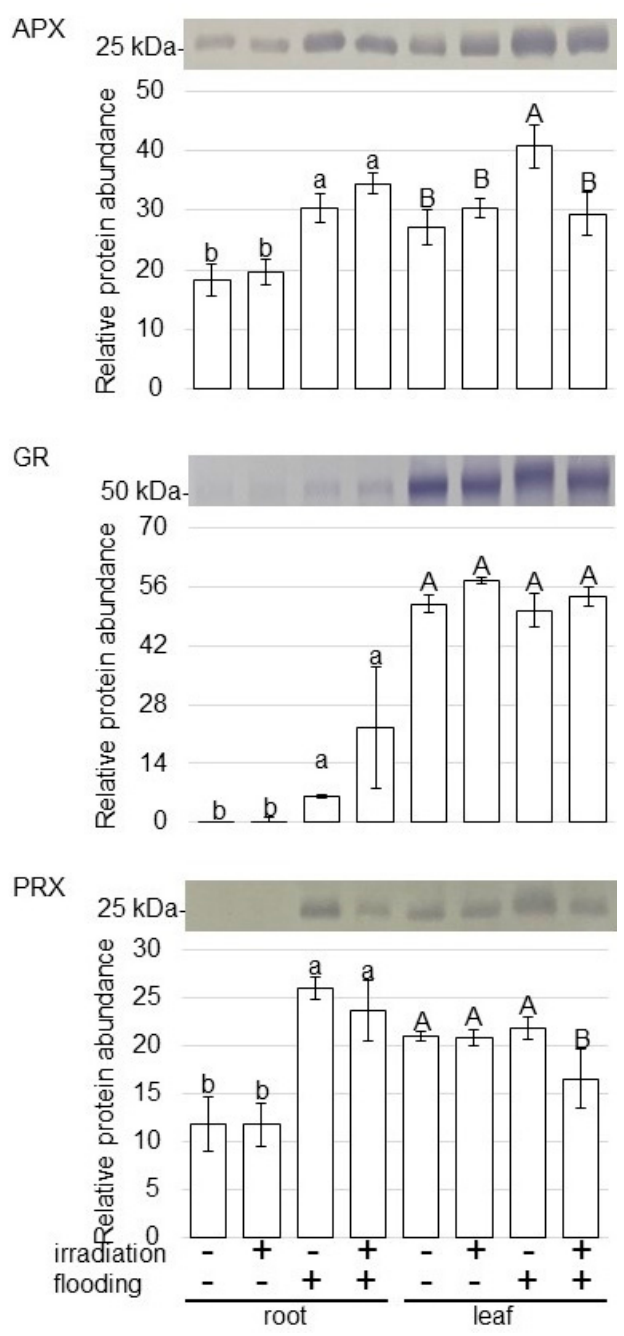
Figure 6. Immunoblot analysis of proteins involved in ROS scavenging in wheat irradiated with millimeter waves under flooding stress. Proteins extracted from roots and leaves of wheat seedlings were separated on SDS-polyacrylamide gel by electrophoresis and transferred onto membranes. The membranes were cross-reacted with anti-APX, GR, and PRX antibodies. Staining pattern with Coomassie-brilliant blue was used as a loading control (Figure S4). The integrated densities of bands were calculated using ImageJ software. The data are given as the mean ± SD from three independent biological replicates (Figures S8–S10). The statistical analysis is same as Figure 4.